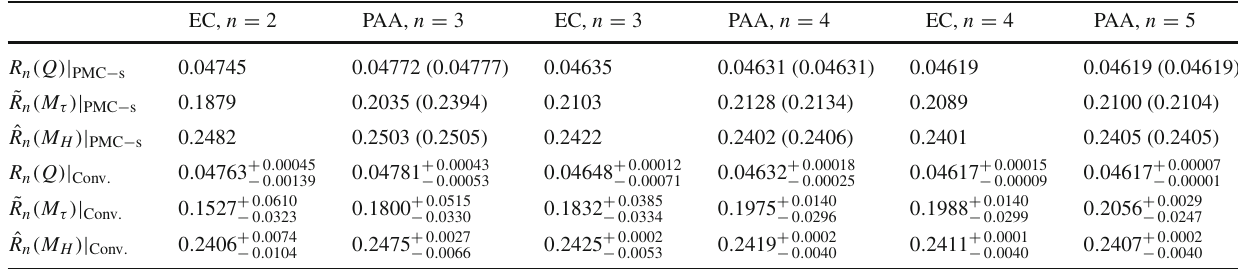
[ 0 / n − 1 ] -typePAAprediction(Thevaluesintheparenthesesareresults for the corresponding full PAA series). The PMC predictions are scale independent and the errors for conventional scale-setting are estimated by varying the initial renormalization scale μ r within the region of [ 1 / 2 μ , 2 μ ] , where μ = Q , M τ and M H , 0 0 0